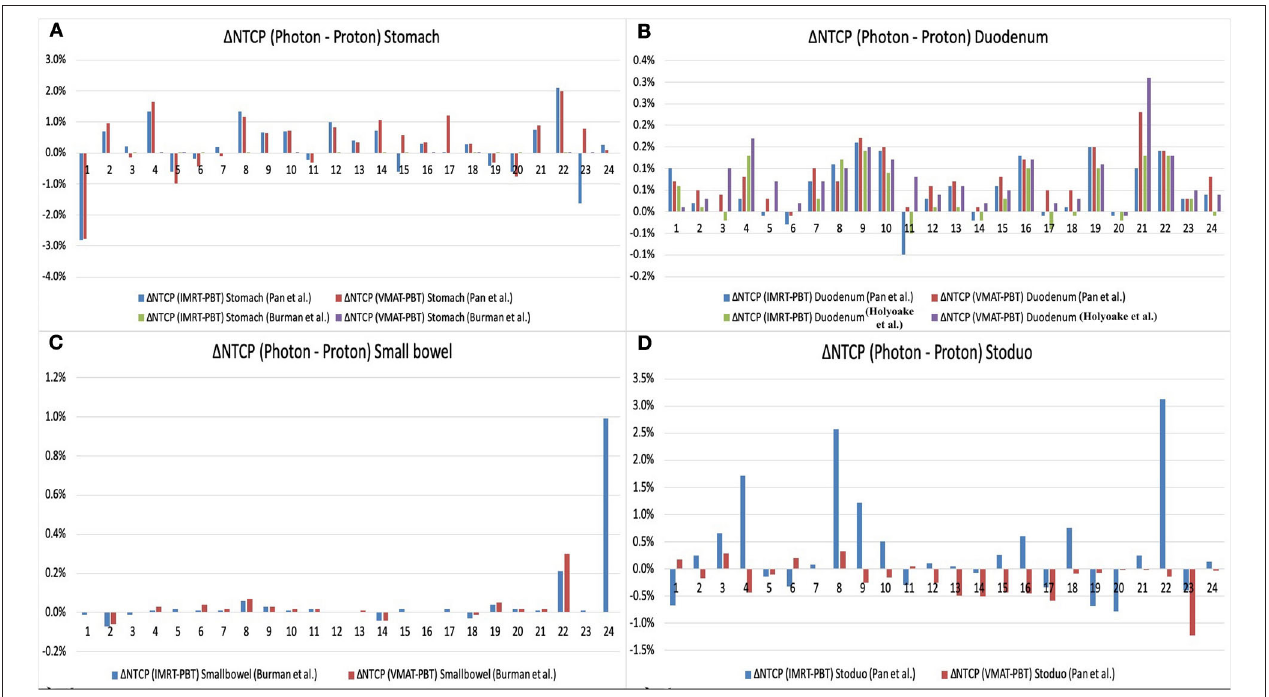
FIGURE 5 | Normal tissue complication probability (NTCP) reduction ( 1 NTCP Photon bowel (C) , and stoduo (D) ] for proton therapy (3D-PSPBT) calculated using Lyman–Kutcher–Burman (LKB) model parameters from Pan et al., Burman et al., and Holyoake et al. (graph: on the X -axis are the patient numbers from 1 to 24; on the Y -axis are the 1 NTCP Photon